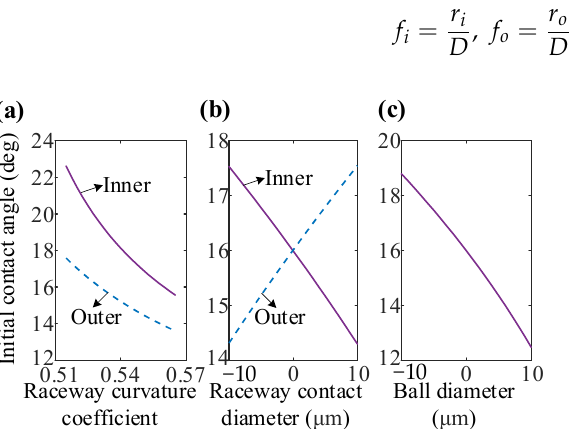
Figure 12. The influences of structural parameters on bearing initial contact angle: ( a ) inner/outer raceway curvature coefficients f i/o ; ( b ) raceway contact diameters d i/o ; ( c ) ball diameter D .